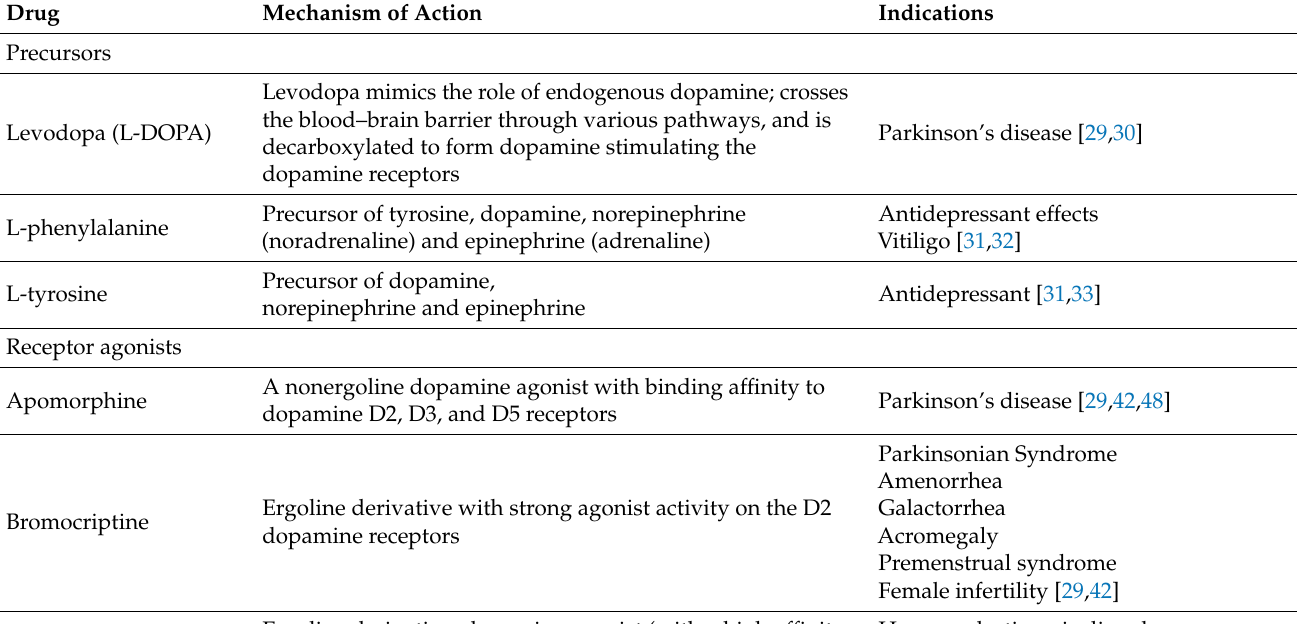
Table 1. Mechanism of action and indications of dopamine precursors and dopaminergic agonist and antagonist